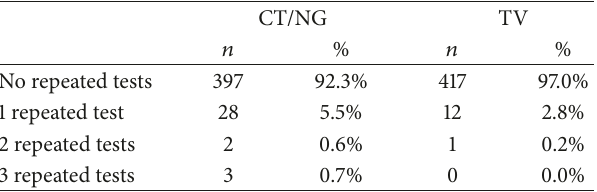
Table 4: Number of repeat Xpert CT/NG and Xpert TV testing performed on HIV infected pregnant women in three clinics in Tshwane District, South Africa. CT/NG TV 𝑛 % 𝑛 % No repeated